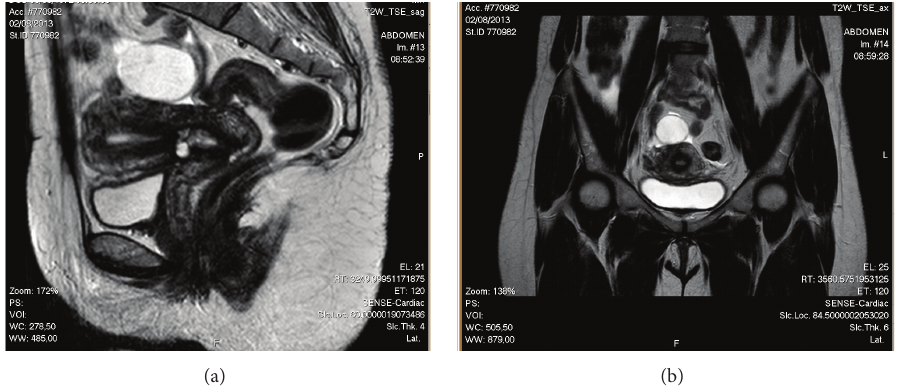
Figure 4: MRI: T2-weighted imaging. (a) Sagittal view. (b) Coronal view: left ovarian cyst.